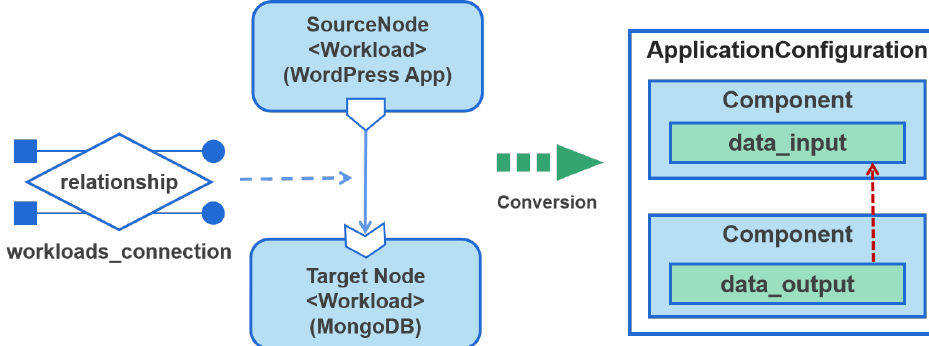
Figure 8. Conversion of Workloads_Connection Relationship from TOSCA to